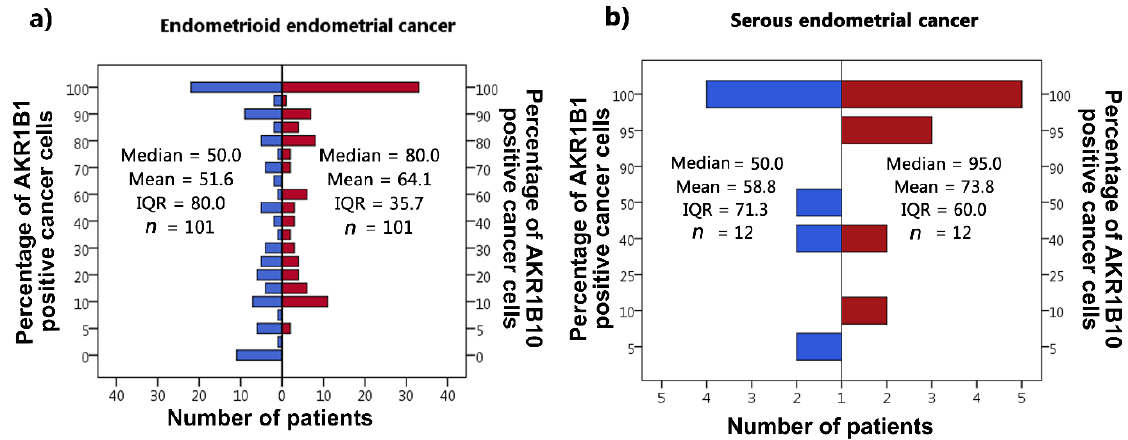
Figure 1. AKR1B1 and AKR1B10 immunohistochemical staining. The percentage of positive cancer cells is shown for ( a ) endometrioid EC and ( b ) serous EC. AKR1B1: aldo-keto reductase family 1 member B1; AKR1B10: aldo-keto reductase family 1 member B10; IQR: interquartile range; N: number of patients.